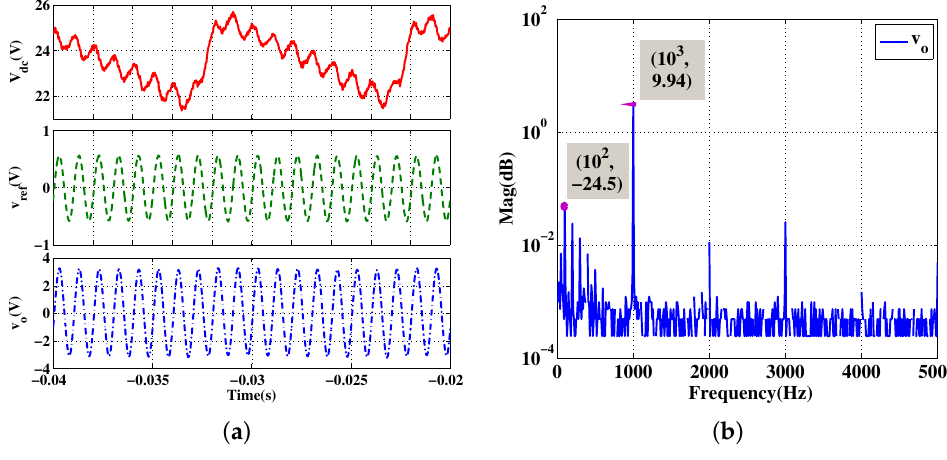
Figure 25. ( a ) Waveforms for PSR test. ( b ) FFT plot of v o